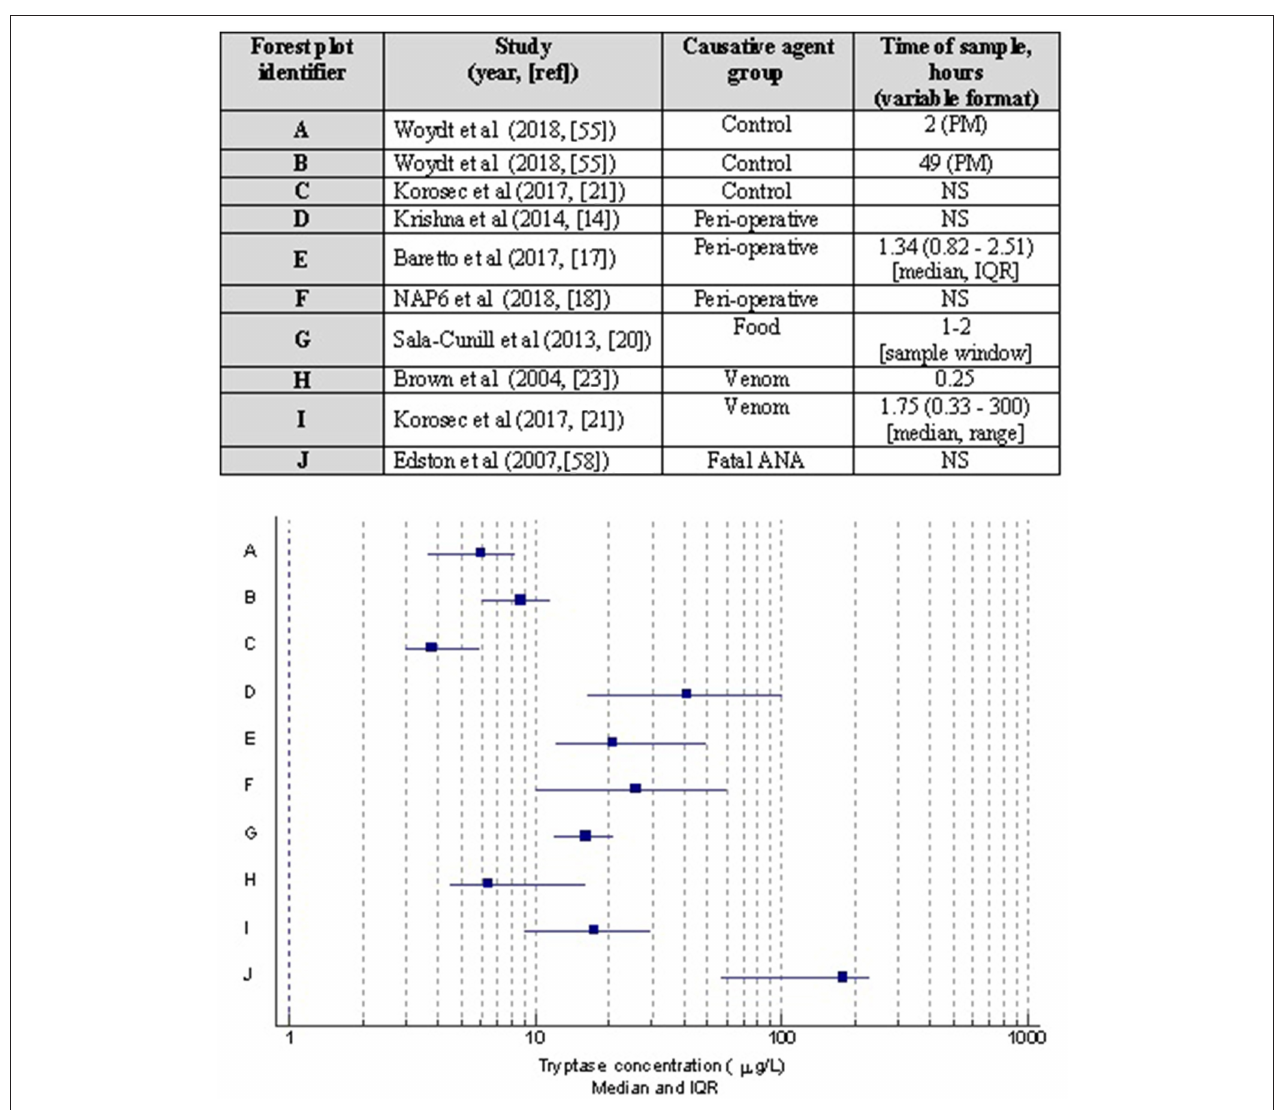
FIGURE 2 | Forest plot showing median and interquartile ranges of acute MCT concentrations based on studies with different causative agents/settings of anaphylaxis. Corresponding table details the publication with 1st author, year, and reference; allergen inducing anaphylaxis, and MCT sampling time was taken for analysis. Note studies are limited to those where such data was presented. PM, post mortem; NS, not